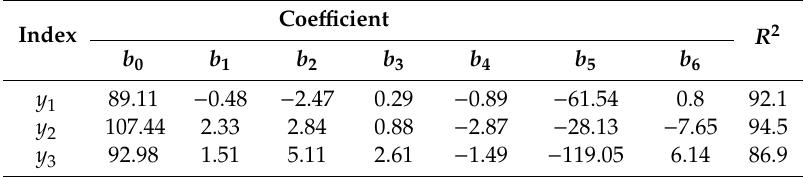
Table 12. Test data fitting.